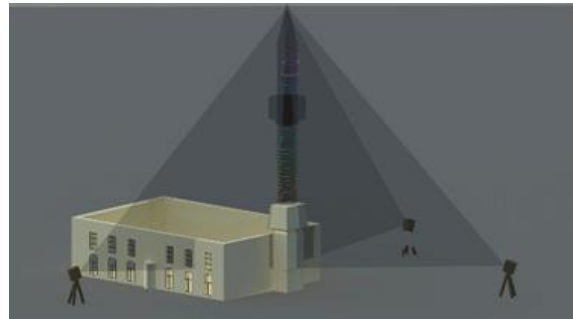
Figure 5. The scanning geometry from three points.